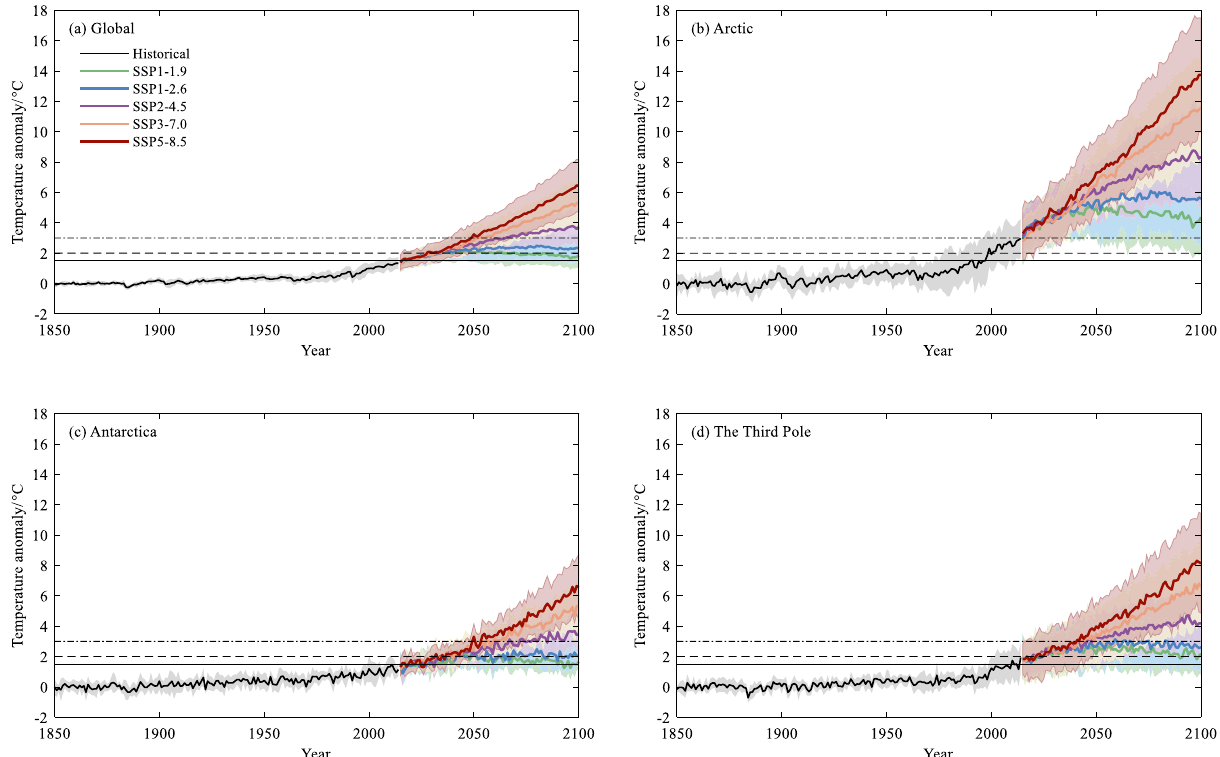
Figure 3. Annual mean surface air temperature anomaly (°C, 1850–1900 as the baseline period) for ( a ) Global, ( b ) Arctic, ( c ) Antarctica and ( d ) The Third Pole during 1850–2100 from multi-model ensemble mean (MMEM) of the CMIP6 simulations under the historical (black curve), SSP1-1.9 (green), SSP1-2.6 (blue), SSP2- 4.5 (purple), SSP3-7.0 (orange), SSP5-8.5 (bronze/crimson), respectively. The black straight lines are for 1.5 °C (solid line), 2.0 °C (break line), 3.0 °C (breakpoint line),